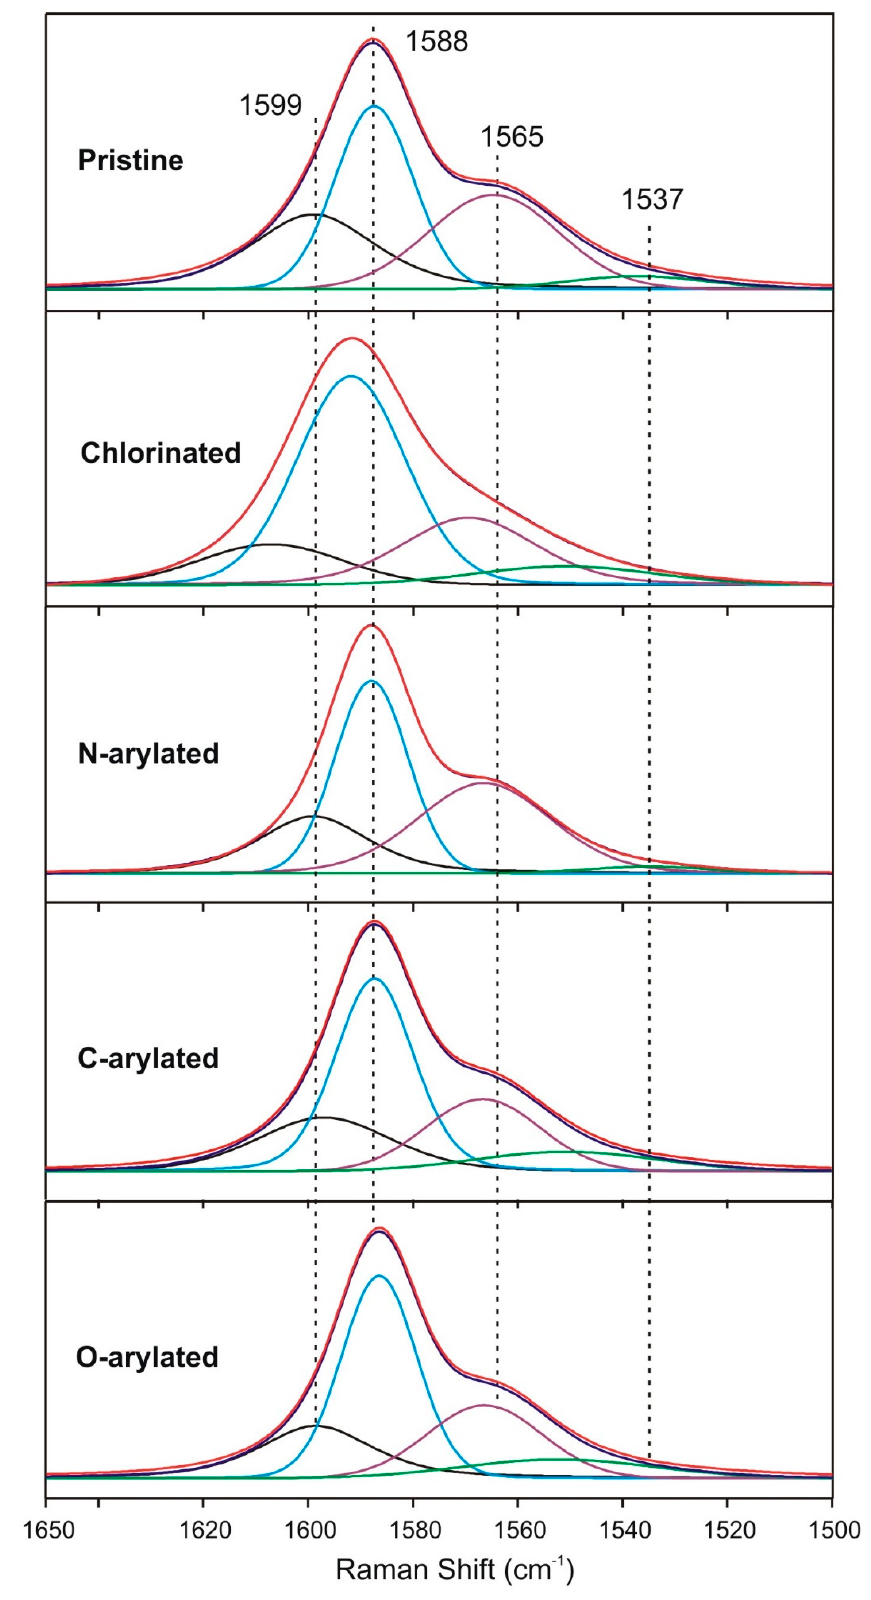
Figure 5. The G-band range after deconvolution for pristine and functionalized single-walled carbon nanotubes (SWCNTs).